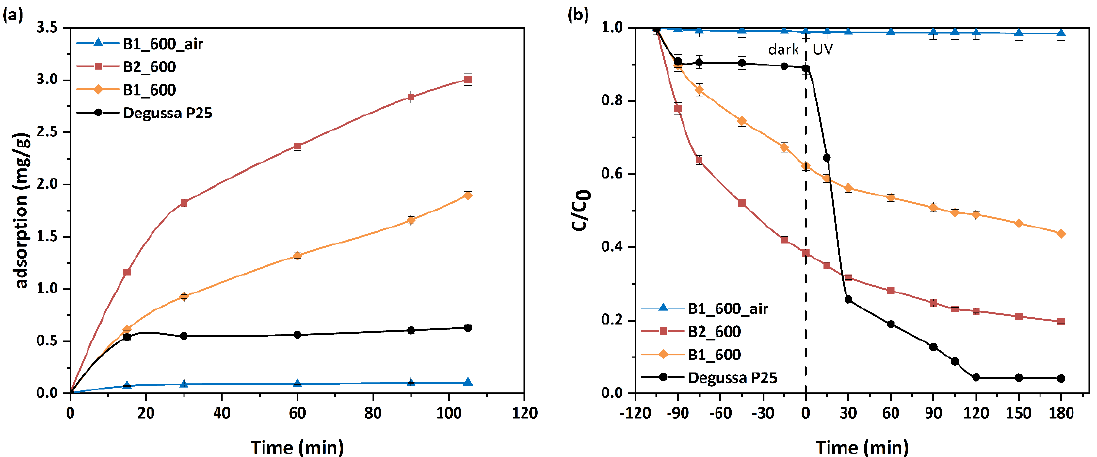
Figure 5. ( a ) Adsorption kinetics curves for MO adsorption at a concentration of 12 ppm of fresh beads samples in comparison to MO adsorption of Degussa P25 TiO 2 (pH = 6, 25°C). ( b ) Kinetics of MO photocatalytic degradation for all samples in comparison to MO degradation of Degussa P25 TiO 2 (UV irradiation, C 0 = 12 ppm, pH = 6, 25°C).